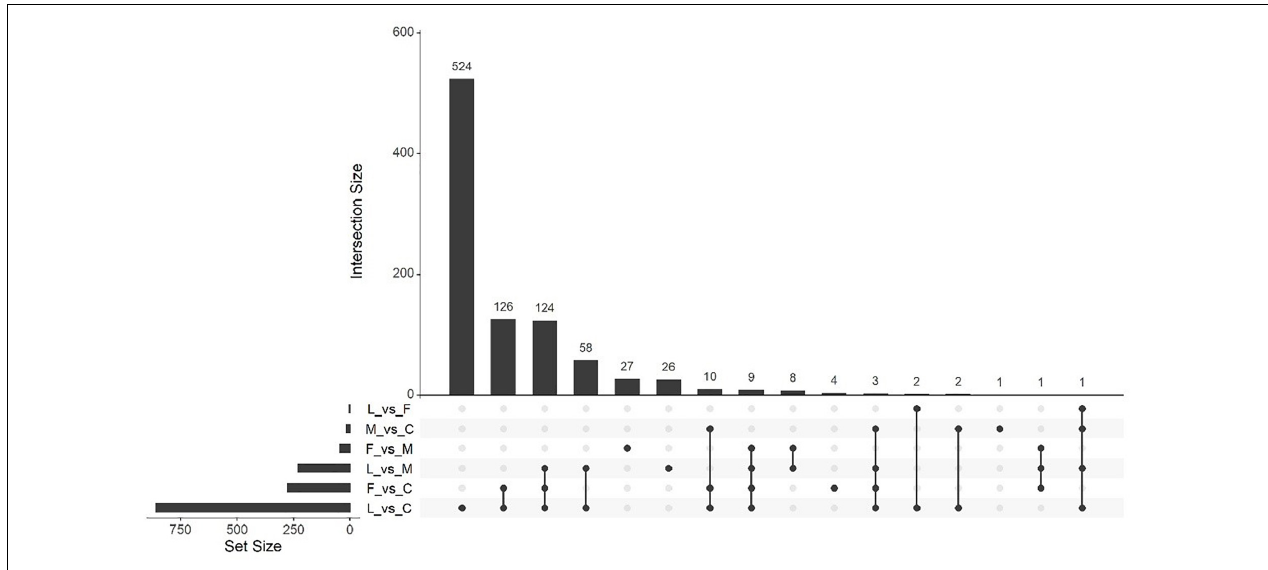
FIGURE 8 | UpSetR plot showing numbers of downregulated differentially expressed genes (DEGs), ( p < 0.05) and Log2 fold change ( ≥ 2.0). Any DEGs common to plant treatments are shown by connected dots. Cumulative numbers of DEGs are calculated by adding numbers associated with dots in each respective treatment